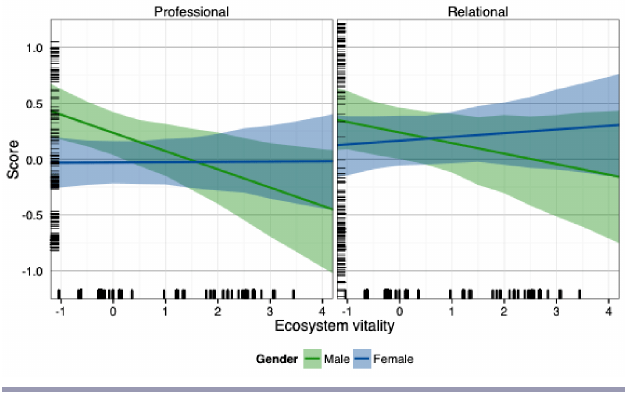
Fig. 5 . Women’s participation in professional and relational dimensions is only slightly affected by ecosystem vitality, while men’s participation on these dimensions declines as ecosystem vitality increased. Dimensions of participation are plotted on the y-axis and conditioning variables on the x-axis. Plots show model predictions (with unplotted variables held at constant values) and 95% Highest Posterior Density bands. Rug plots along each axis show the distribution of individual responses.